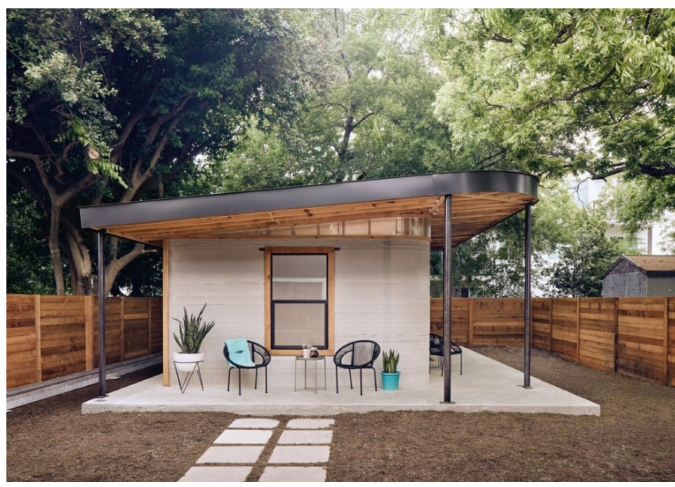
Figure 3. Chicon House [22]. Reprinted with permission from Ref. [22]. 2018,